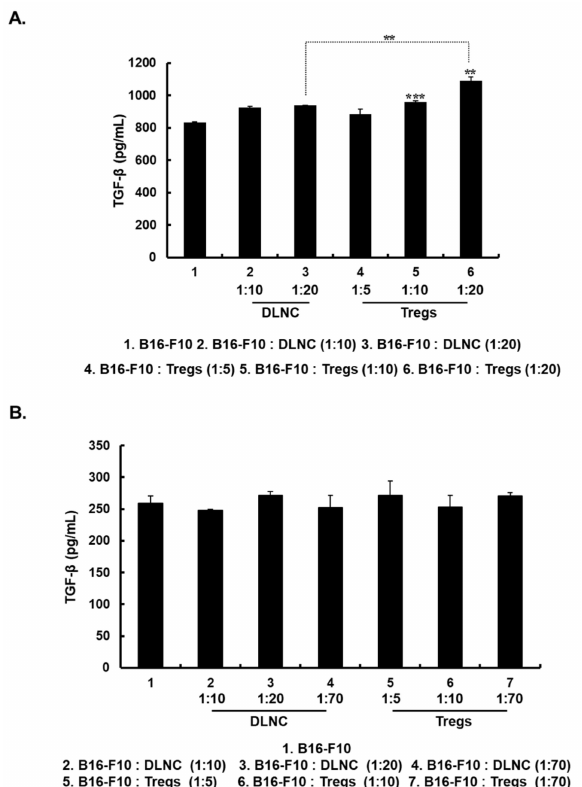
Figure 2. Expression of transforming growth factor- β (TGF- β ) in B16-F10 cells. ( A ) B16-F10 cells were co-cultured with DLNC or Tregs at various co-culture ratios in 6-well plates and the TGF- β expression level in culture supernatants was measured at 72 h after incubation began by enzyme-linked immunosorbent assay (ELISA). Data are presented as mean ± SD of triplicates that are representative of 3 independent experiments. ** p < 0.01, B16-F10: Tregs (1:20) versus B16-F10 or B16-F10: DLNC (1:20). *** p < 0.001 versus B16-F10. ( B ) B16-F10 cells were physically separated from co-cultured DLNC or Tregs by 24-well transwell chamber. TGF- β expression level in the culture supernatant of lower chamber was measured at 72 h after incubation by ELISA. Data are presented as mean ± SD of triplicates that are representative of 3 independent